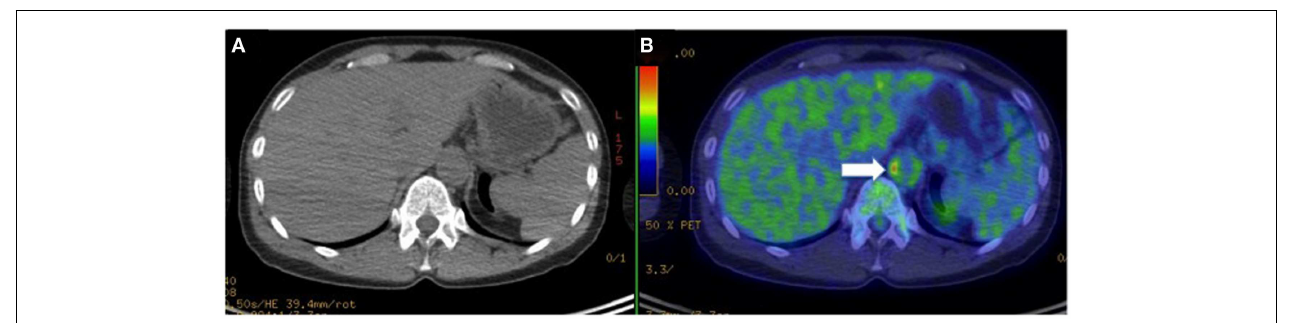
FIGURE 5 | Hybrid CT (A) with PET imaging (B) to identifies [ 18 F]-fluorodeoxyglucose (FDG) accumulation in the vascular wall of abdominal aorta (arrow) in a female patient withTakayasu arteritis .